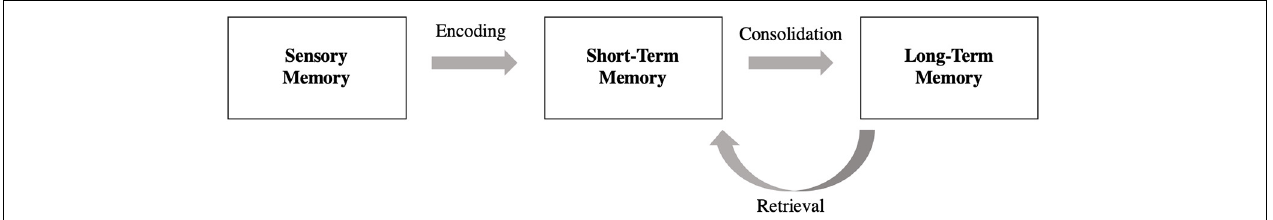
FIGURE 1 | Multimodal memory model and associated cognitive processes: the sequential model begins with sensory memory and ends with long-term memory. Stimuli move through these three memory storage units through cognitive processes known as: encoding, consolidation, and retrieval.